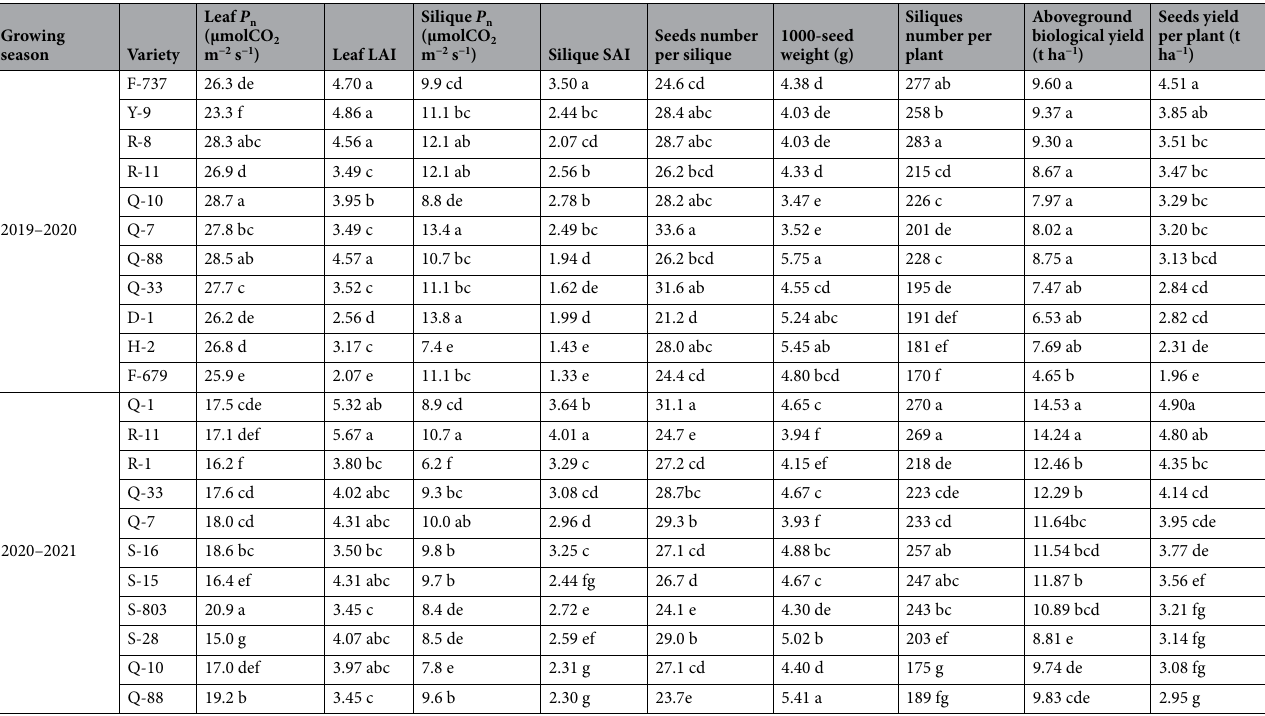
Table 2. The photosynthetic indexes and yields of different rapeseed varieties in the comparing experiment. LAI, leaf area index; SAI, silique surface area index; P n , net photosynthetic rate. Different lowercase letters in same column indicated significant differences ( P < 0.05). The same